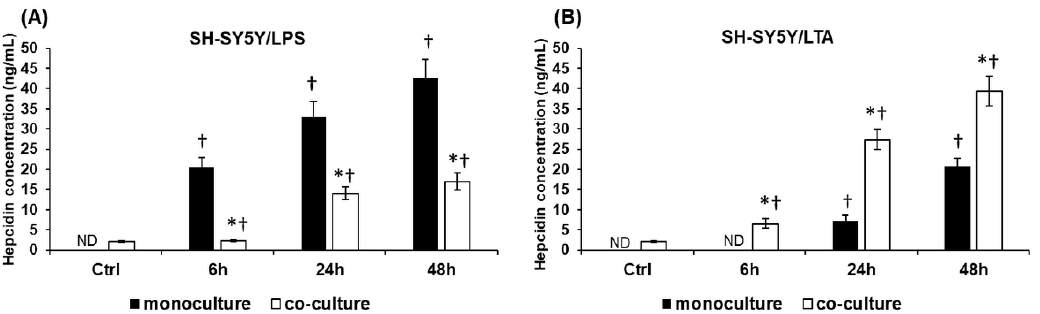
hepcidin content of each sample was determined with Hepcidin 25 bioactive ELISA Kit. ( A ) Hepcidin concentrations in the cell culture media of the LPS-treated SH-SY5Y monocultures and co-cultures. ( B ) Hepcidin productions of the LTA treated mono- and co-cultured SH-SY5Y cells measured from the culture medium. The columns represent mean values and error bars represent standard errors of the mean (SEM) of four independent determinations. The hepcidin contents of the control media did not change during the experiments therefore only one control was represented in the figures. Asterisk marks p < 0.01 between the mono- and co-cultures. Cross means p < 0.01 compared to the controls. ND means not detected.